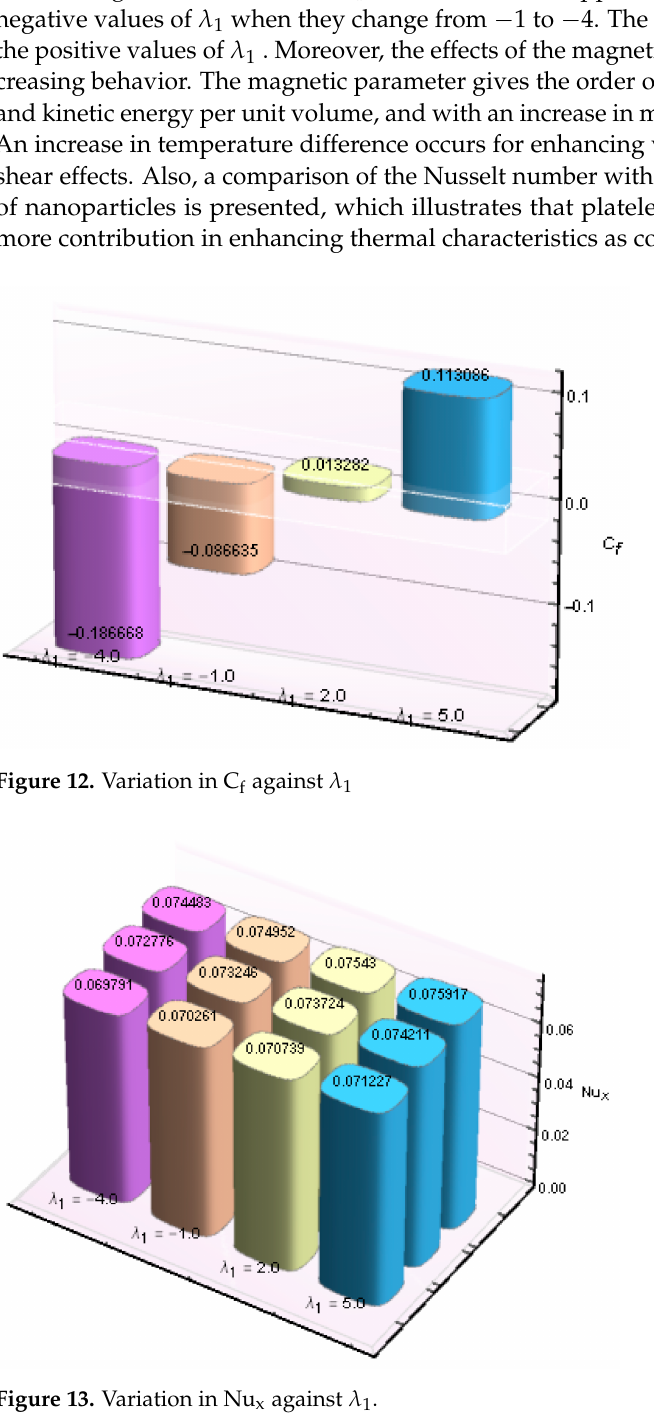
Figure 13. Variation in Nu x against λ 1